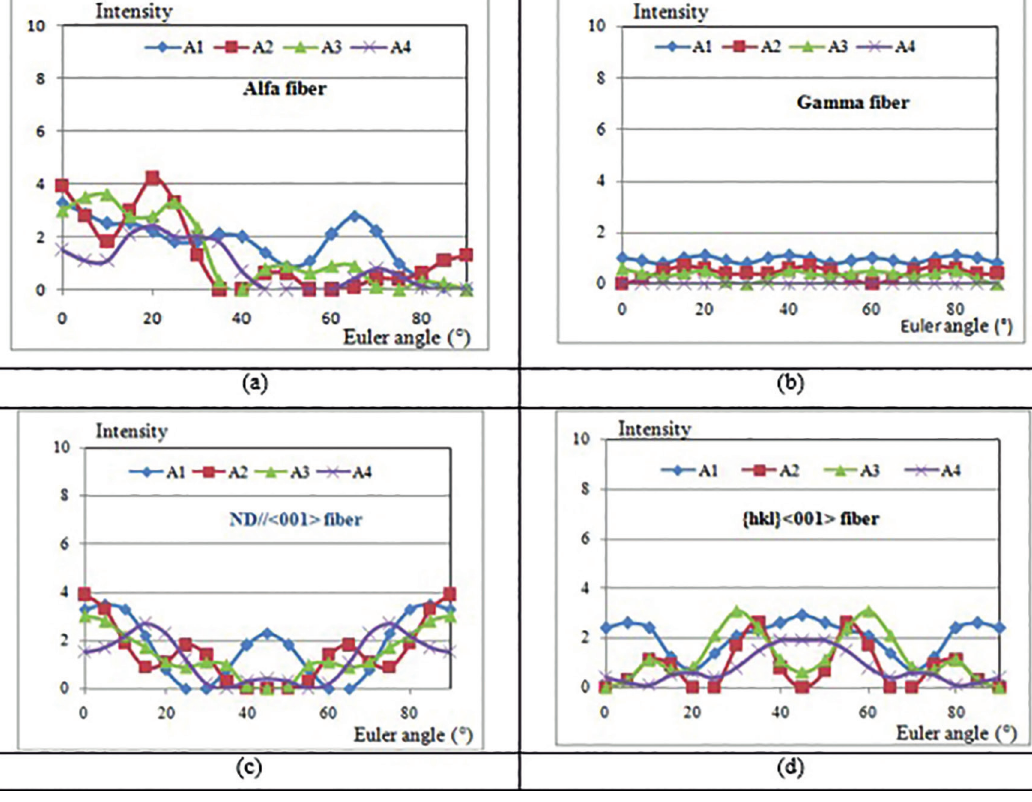
Figure 3: Fiber figures: (a) Alfa, (b) Gamma, (c) Cubic and (d)